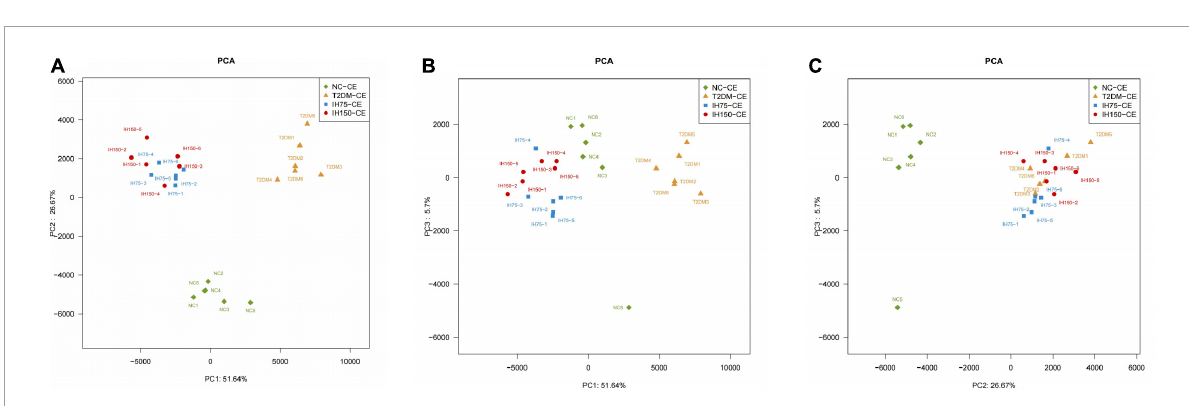
FIGURE7 Principal coordinate analysis (PCA) of the bacterial structure of the mouse cecal contents. (A–C) Are PCA from different